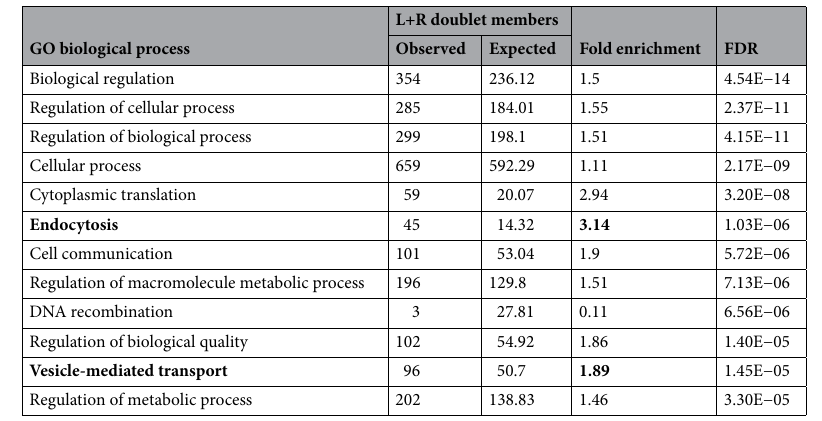
Table 1. Significantly enriched biological processes among L+R doublet members in S. cerevisiae , ranked by FDR. Processes related to vesicle traffic are in